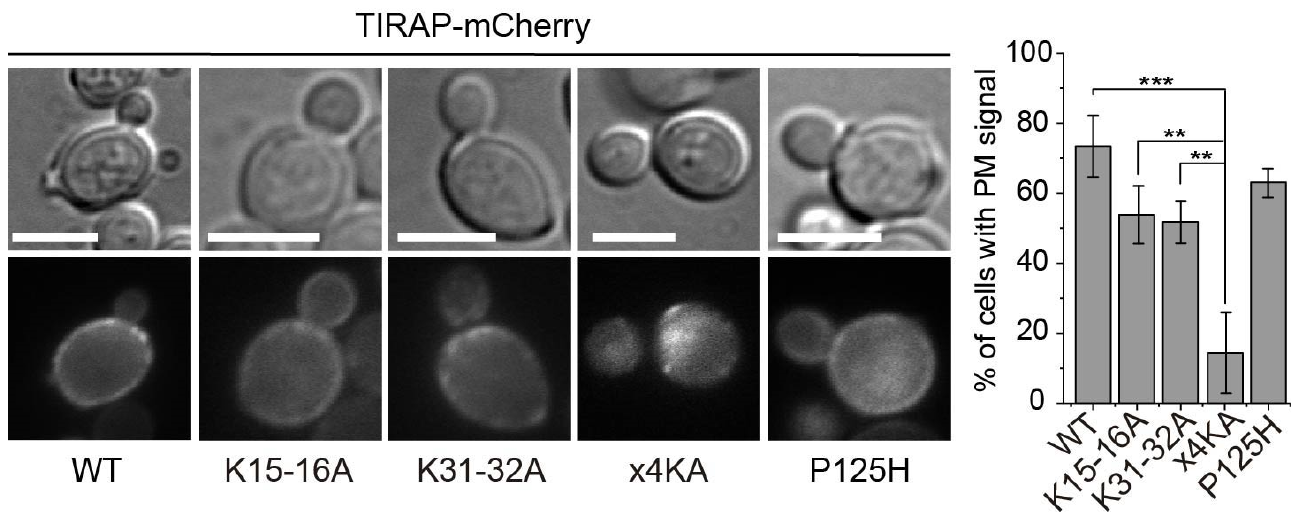
Figure 2. The TIRAP polybasic region targets it to the yeast PM. Differential interference contrast and fluorescence microscopy of YPH499 yeast cells expressing WT TIRAP-mCherry and the indicated mutants from pYES3 derivative plasmids (left). Graph displaying the percentage of cells showing PM mCherry fluorescent signal (right). Data correspond to means ± standard deviation of three independent transformants ( n > 100). Normality was checked by the Shapiro–Wilk test. One-way ANOVA statistical comparison produced a p -value < 0.001 (***) for × 4KA vs. WT [ p = 4.8 × 10 − 5 ], and a p < 0.01 (**) vs. K15-16A ( p = 0.00147) and K31-32A ( p = 0.00222). Scale bars correspond to 5 µ m.